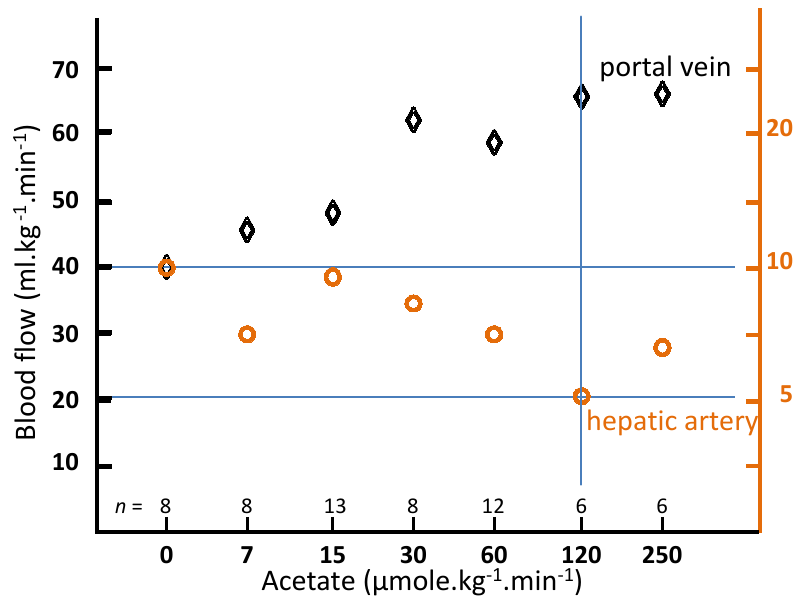
Figure 3. Portal and arterial hepatic blood flow in conscious rats as a function of the acetate infusion rate after 10 min of infusion (derived from [19]).